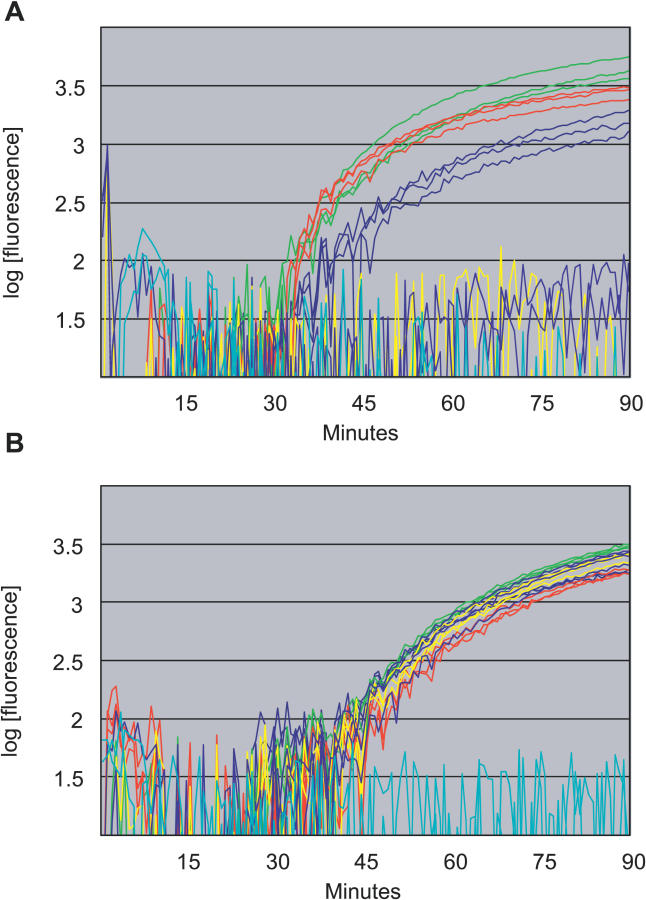
A Multiplex RPA Approach Enables Detection of Different MRSA Alleles and an Internal Control in the Same Reaction(A) MRSAI (green), MRSAII (dark blue), MRSAIII DNA (red) at ten copies, or MSSA DNA at 10
4 copies (blue, negative control) or water (yellow, turquoise, negative controls) served as a template (in triplicate for each template condition). See
Figure 3 for the arrangement of primers and probes used.
(B) Detection of 50 copies of internal control DNA included in the reactions in (A). Note that two of the negative control sets (blue, yellow) included internal control template, whereas one set of reactions (turquoise) contained water only and served as “double negative” control.